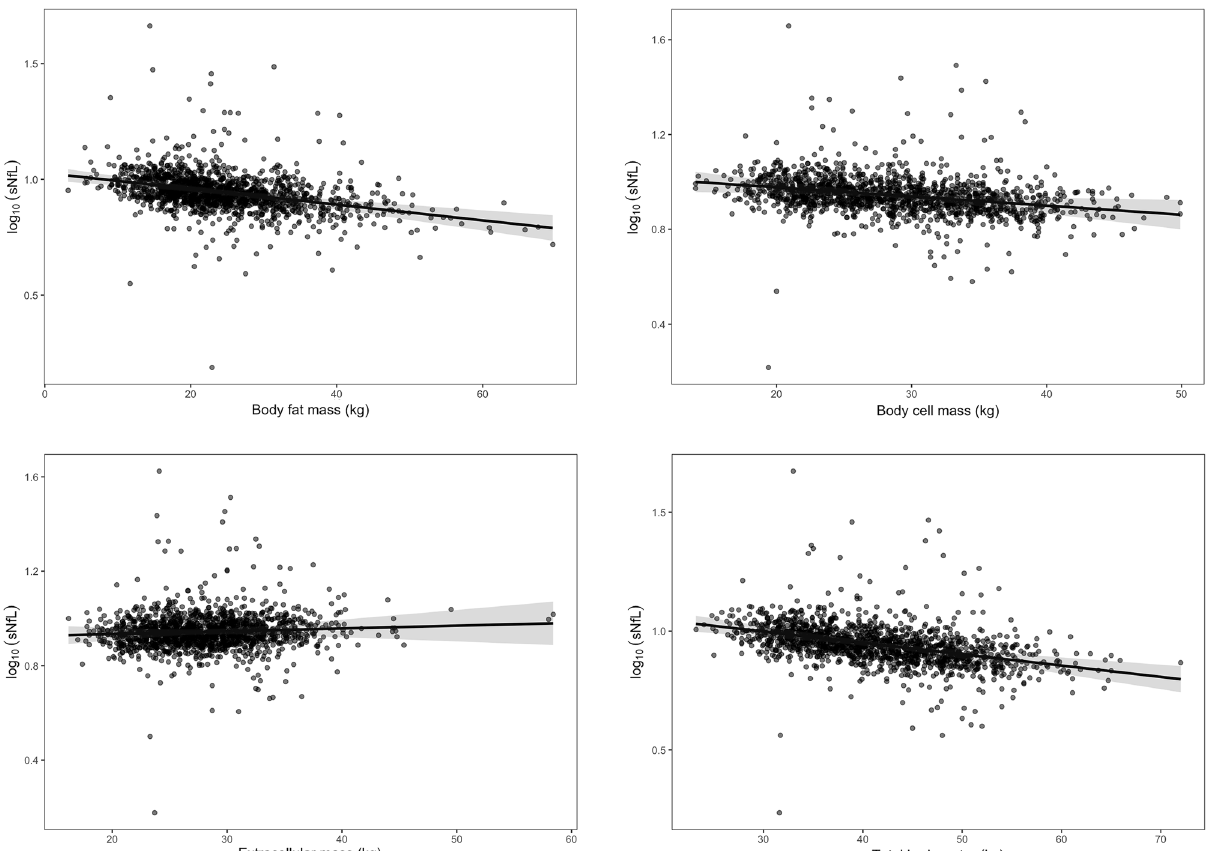
Figure 3. Partial residual plots showing the sex- and age-adjusted inverse associations between sNfL and body fat mass, and extracellular mass, and body cell mass according to the three-compartment model. The bottom right panel shows the sex- and age-adjusted inverse association between sNfL and total body water. The 95% confidence intervals are shown as grayish shaded